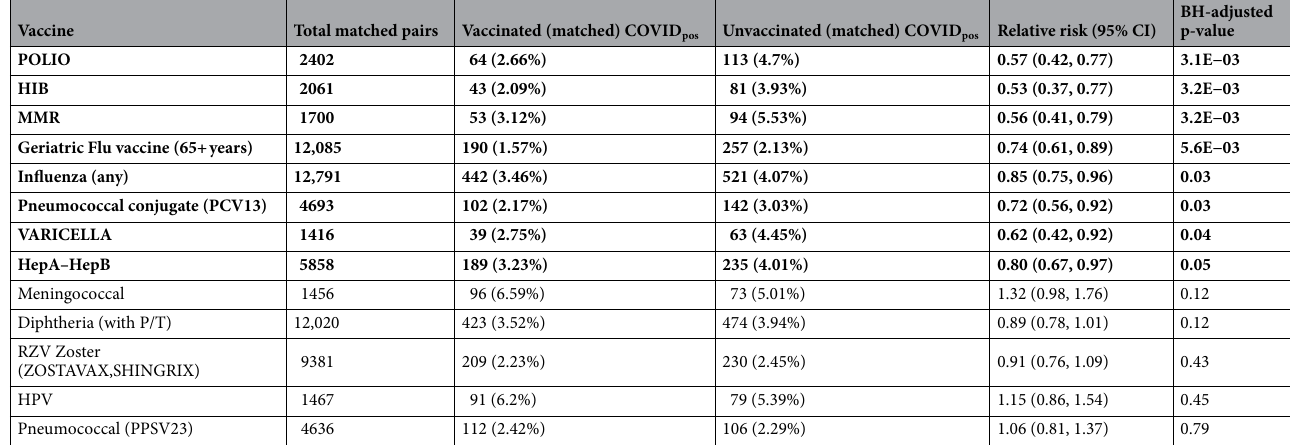
Table 4. Summary of SARS-CoV-2 rates for vaccinated and unvaccinated propensity score matched cohorts (1 year time horizon). Table of SARS-CoV-2 infection rates for vaccinated and unvaccinated (matched) cohorts for vaccines administered within 1 year prior to PCR testing. Rows in which the SARS-CoV-2 rate is lower (adjusted p-value < 0.05) in the vaccinated cohort are highlighted in bold. The columns are (1) Vaccine: Name of the vaccine, (2) Total matched pairs: Number of pairs from the propensity matching procedure, which is the sample size of both vaccinated and unvaccinated cohorts after matching, (3) Vaccinated (matched) COVID pos : Number of COVID pos cases among the vaccinated (matched) cohort, along with the percentage in parentheses, (4) Unvaccinated (matched) COVID pos : Number of COVID pos cases among the unvaccinated (matched) cohort, along with the percentage in parentheses, (5) Relative risk (95% CI): Relative risk of COVID pos in the vaccinated (matched) cohort compared to the unvaccinated (matched) cohort, along with 95% confidence interval in parentheses, (6) BH-adjusted p-value: Benjamini–Hochberg-adjusted Fisher exact test p-value.